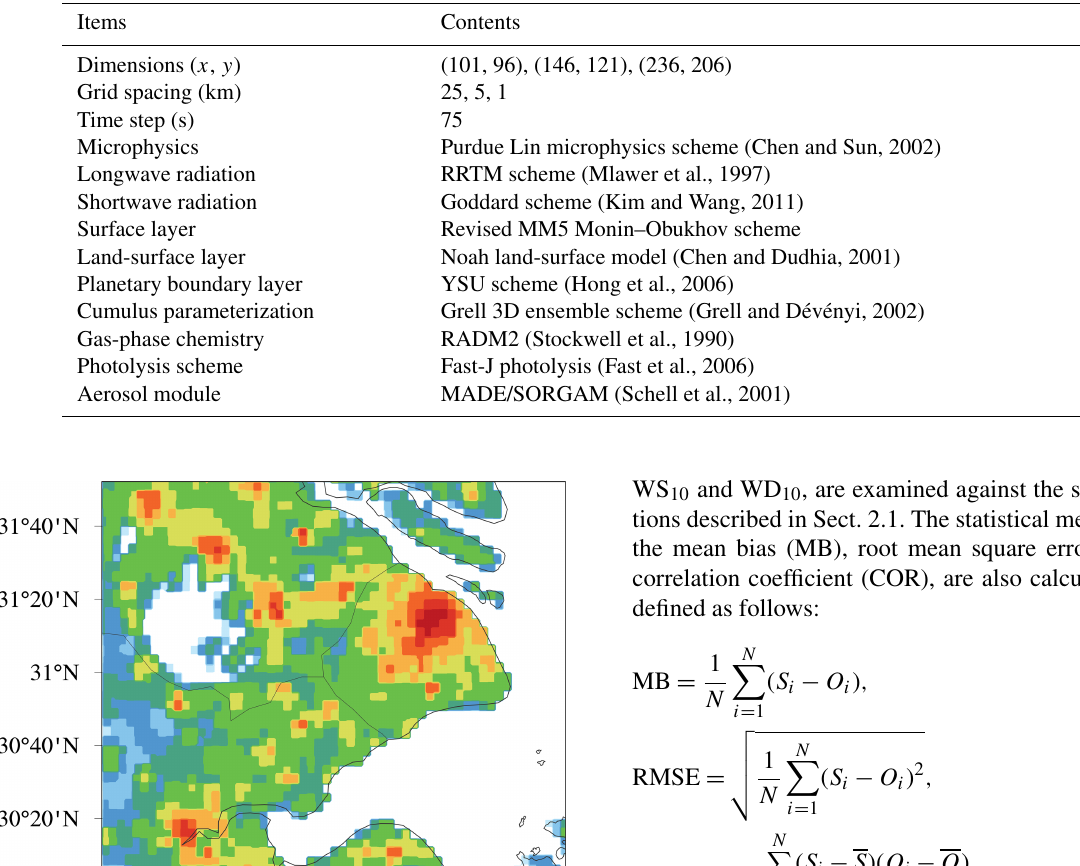
Table 1. The domains and major options for WRF-Chem.